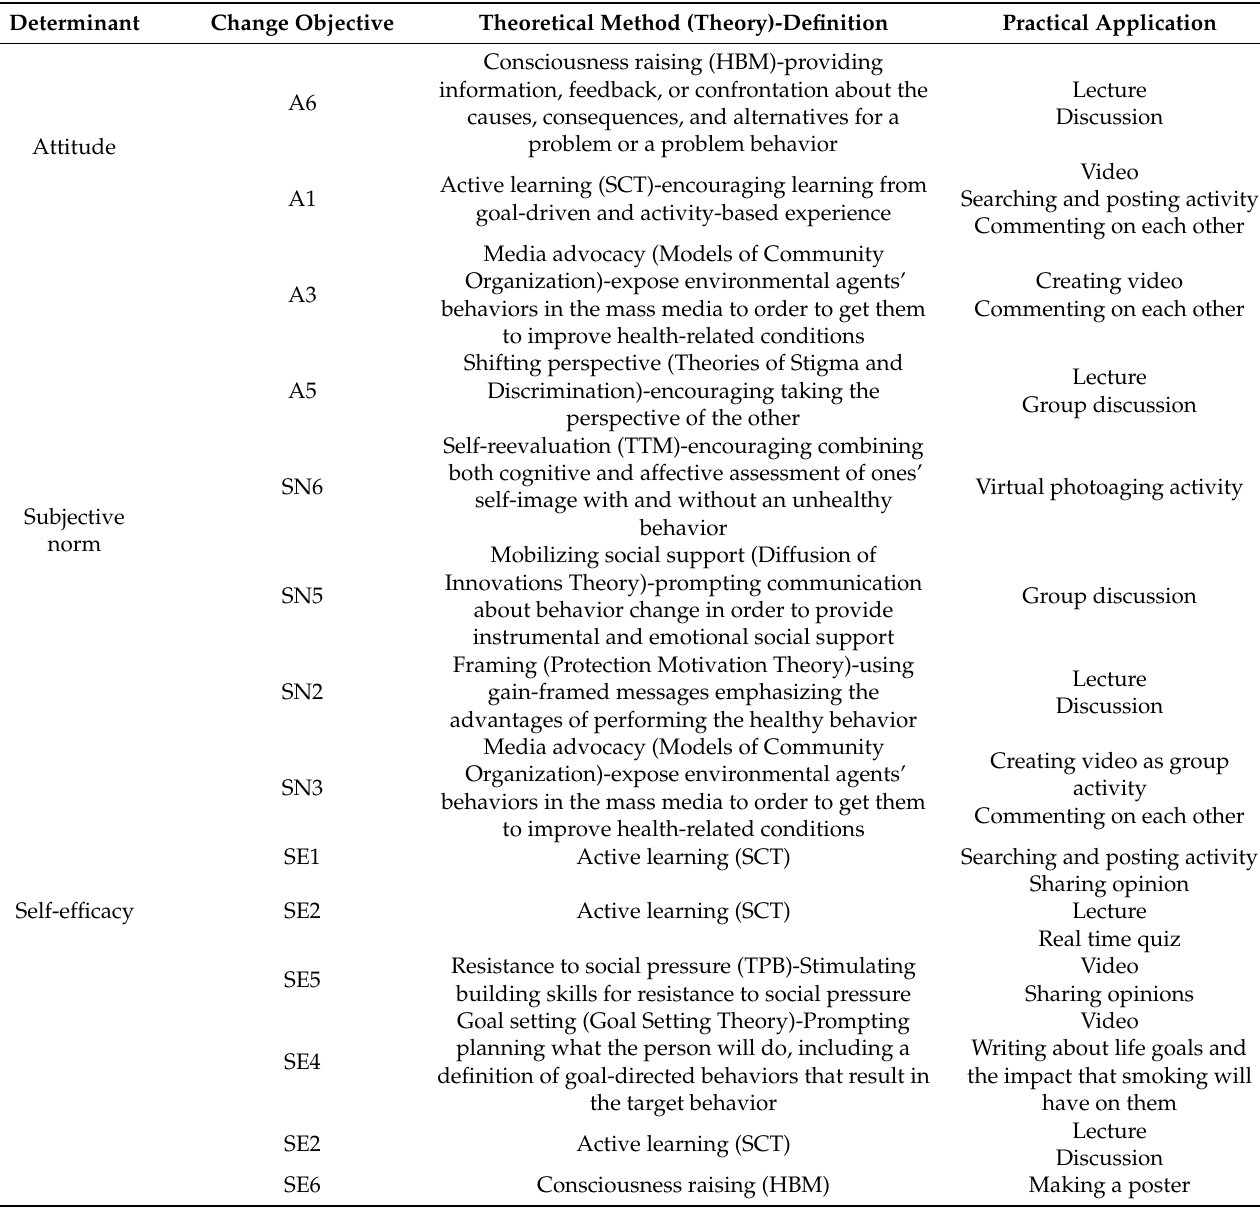
Table 2. Theoretical methods and practical